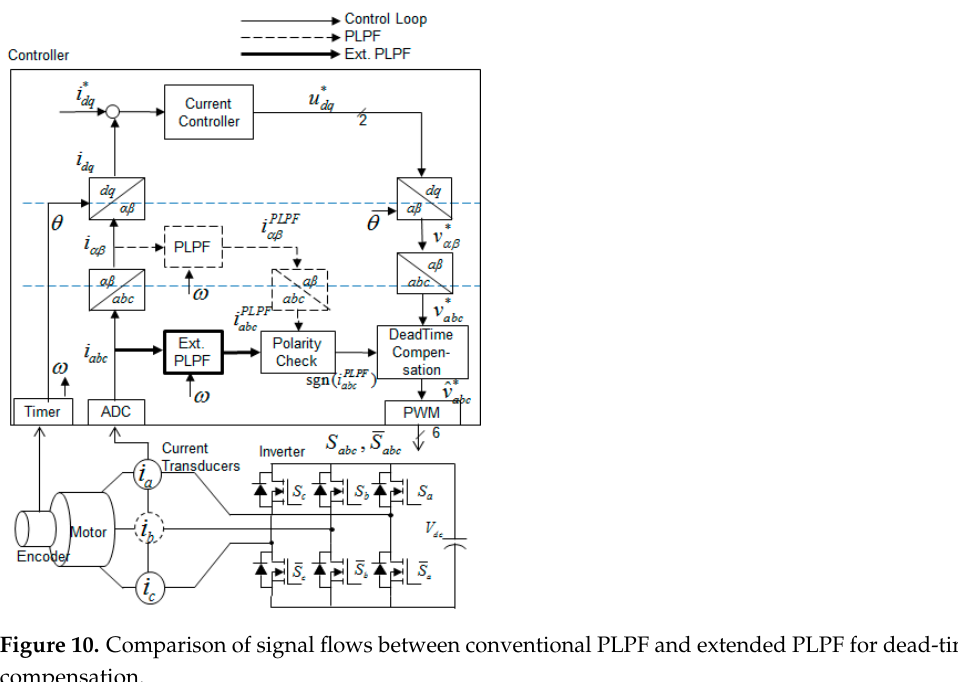
9 of 13 Figure 9. THD analysis results of phase currents according to the compensation methods.